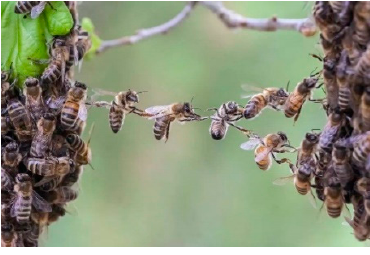
Figure 11. Bee colony.